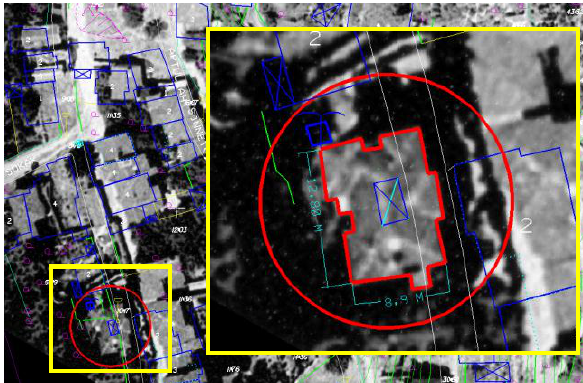
Figure 4. The location of building after the registration of the aerial photograph and digital map and the dimensions of building after the registration of the aerial photograph and digital map